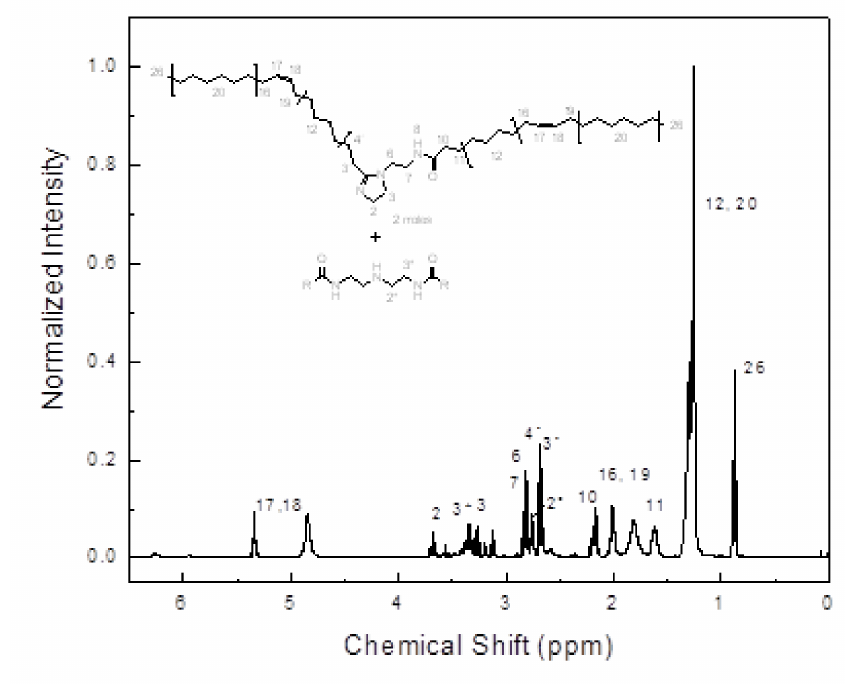
Figure 3. H NMR spectrum of gemini